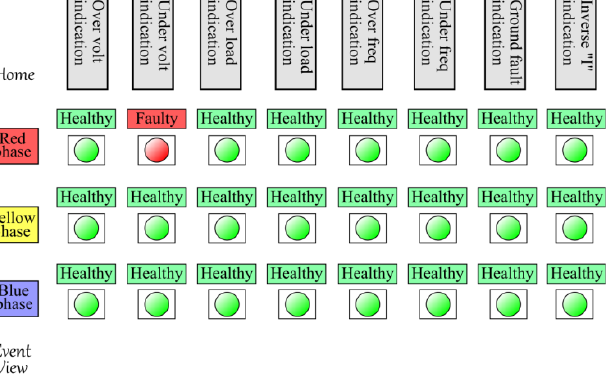
Fig. 8. Fault occurred at single phase undervoltage for digital/analogue relay in HMI.